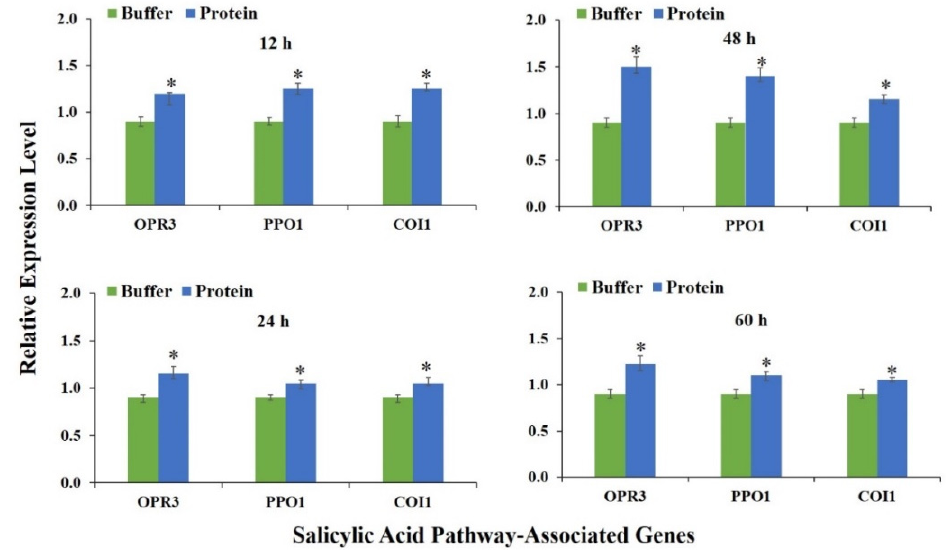
Figure 3. The profiles of relative expression of salicylic acid (SA) plant defense pathway related major genes assessed in the plant leaves treated with a partially purified protein derived from EPF Lecanicillium lecanii at various post-treatment time intervals. Green and blue colored columns represent respectively the results of buffer-treated (control) and protein-treated plants. For each target gene, asterisk shows statistically significant change in both of the treatments (Student’s paired t -test; p ≤ 0.05).